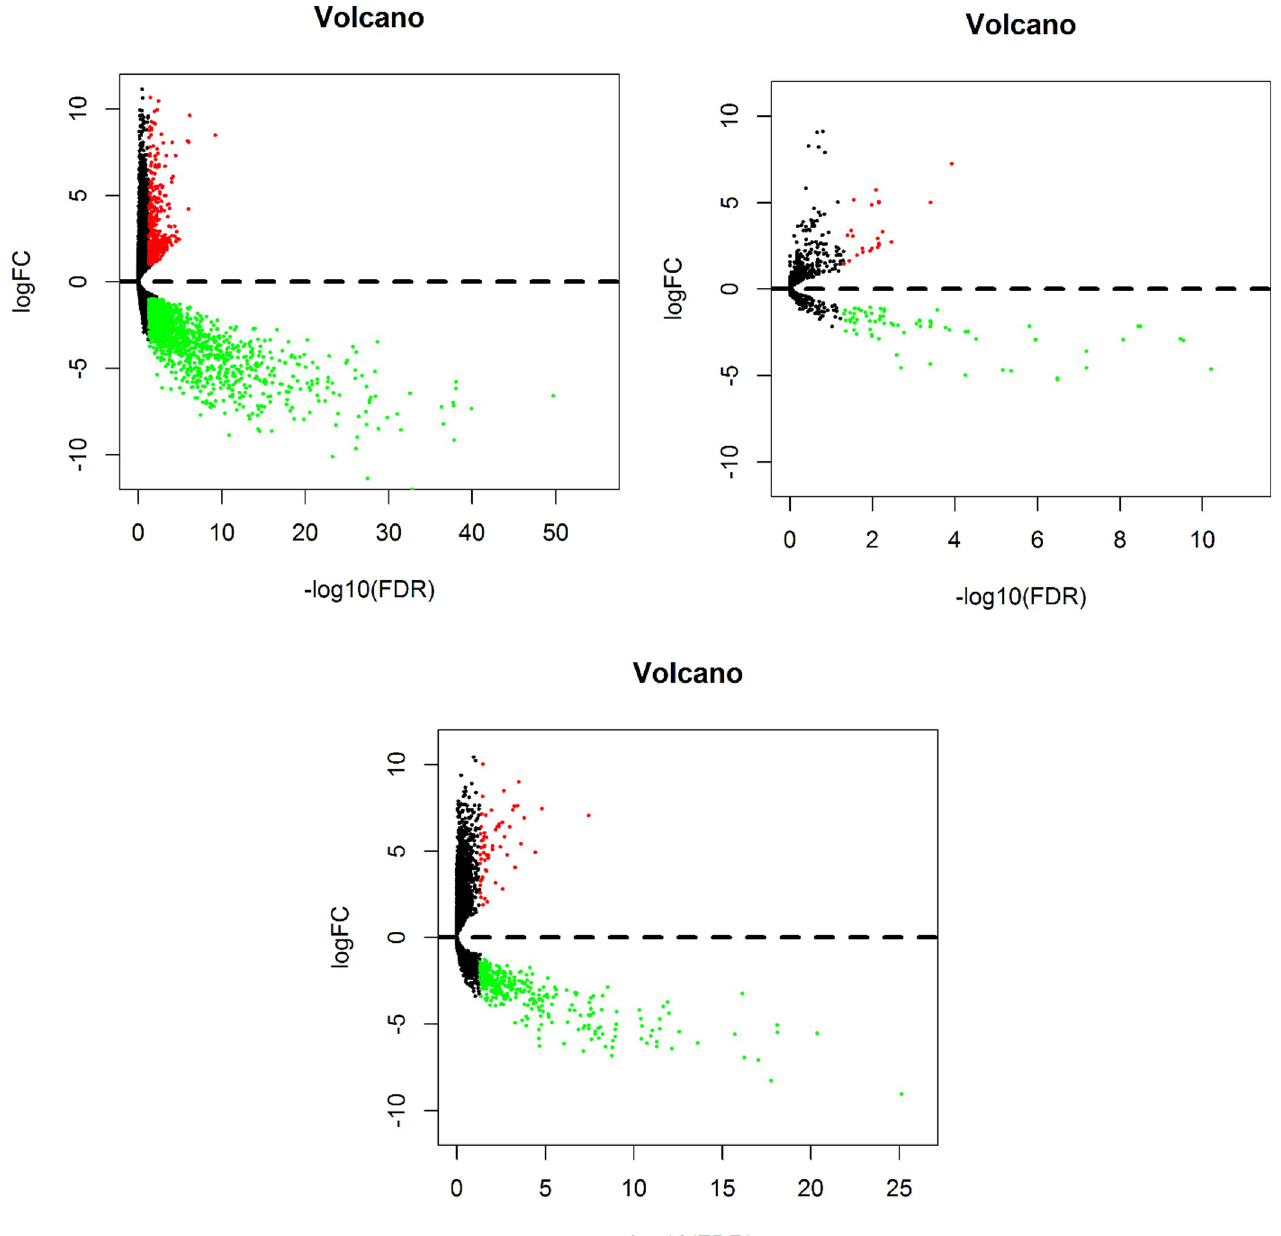
Fig 1. Volcano maps of differentially expressed RNAs in OFSCC patients. (A) mRNA (B) lncRNA (C) miRNA. The red dot represents up-regulated RNA, and green dot represents down-regulated RNA. log2|FC| > 1.0 and P < 0.05 as the selection criteria. OFSCC: Oral Floor Squamous Cell Carcinoma; FC: fold change; lncRNAs: long noncoding RNAs; miRNA: microRNA; mRNA: messenger RNA.